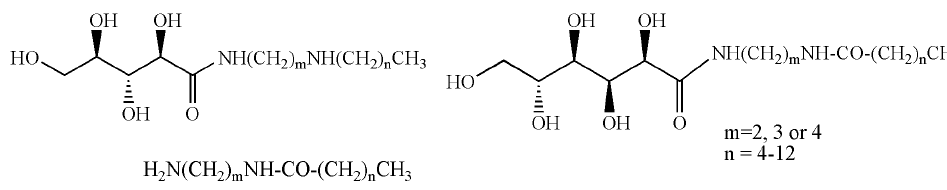
FIGURE 1 . General structure of aldonamides and N -acylated diamines.